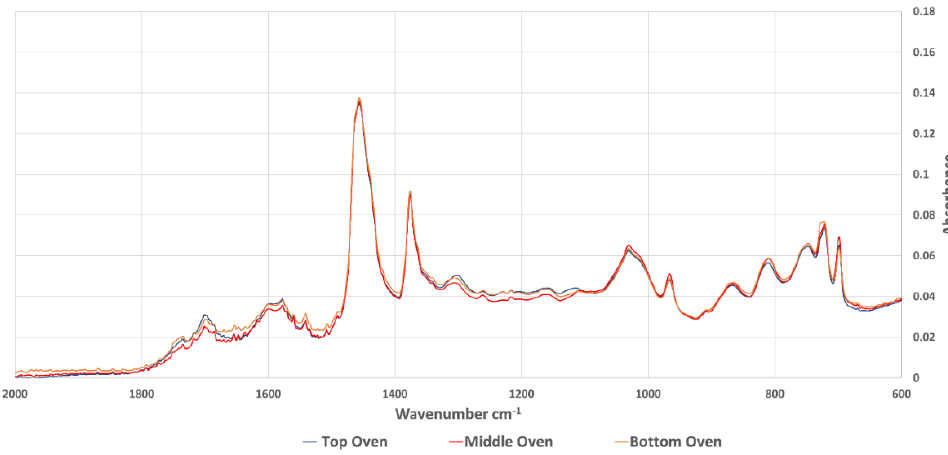
Figure 7. Whole FT-IR spectra for samples aged in the oven.